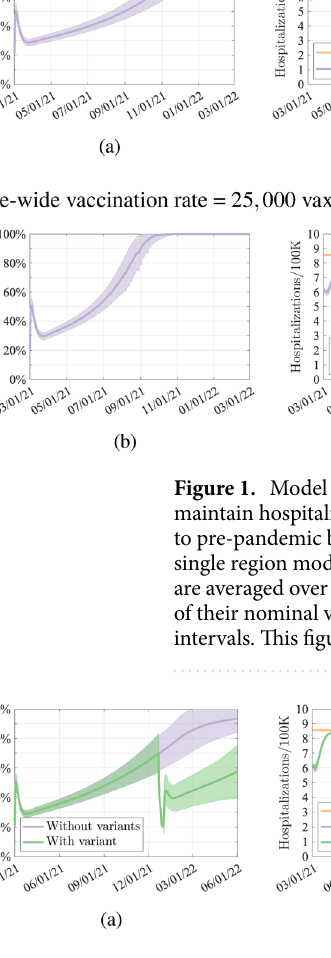
Figure 2. Model and controller behavior without variant (purple and blue lines) and with a more infectious variant (green and blue lines). The effect of the variant is modeled by doubling the transmission rate on 12/21/21. The feedback law is designed to simultaneously maximize contact levels and maintain hospitalizations below the threshold h lim . All simulations are conducted by using a single-compartment model that is fitted using data from the state of Colorado, USA (see “Methods” section). Results are averaged over 10,000 simulations with parameters sampled using a Latin Hypercube technique within 15% of their nominal values. Continuous line shows mean of the trajectory and shaded area show 99.73% confidence